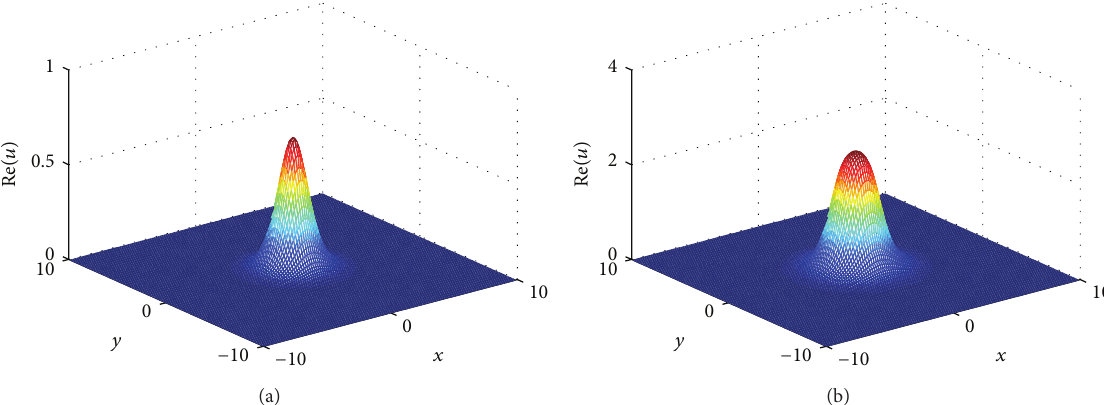
Figure 7: (a) Real part of the lattice soliton profile corresponding to the first renormalization factor with the Penrose potential, 𝑉 0 = 3.5 , 𝐾 = 1 . (b) Real part of the lattice soliton profile corresponding to the second renormalization factors with the Penrose potential, 𝑉 𝐾 = 1